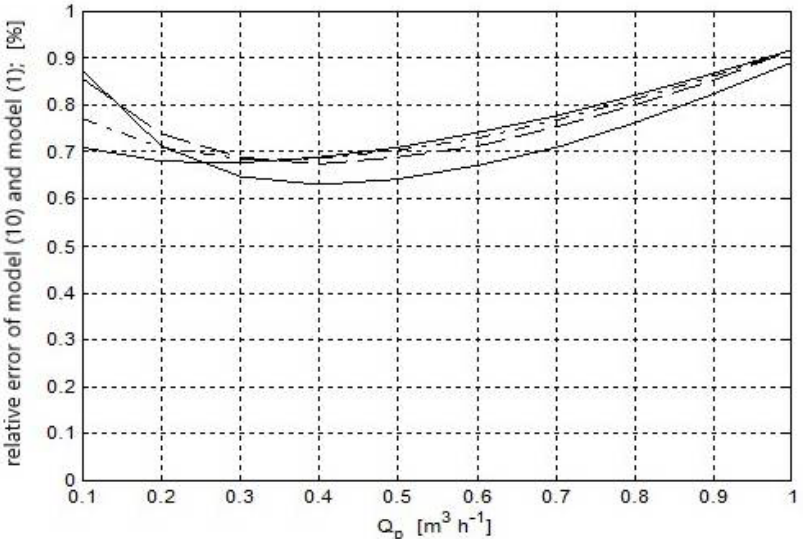
Figure 1. Relative errors of vacuum pressure drops calculated by model (1) and simplified model (10) for D = 0.016 m, H = 0.4 m, l dpm = 0.7 m, p o = 58.0 kPa and ξ = 0.5, λ = 0.03 for selected values of the milk stream in the range from 2 to 10 kg min − 1 .